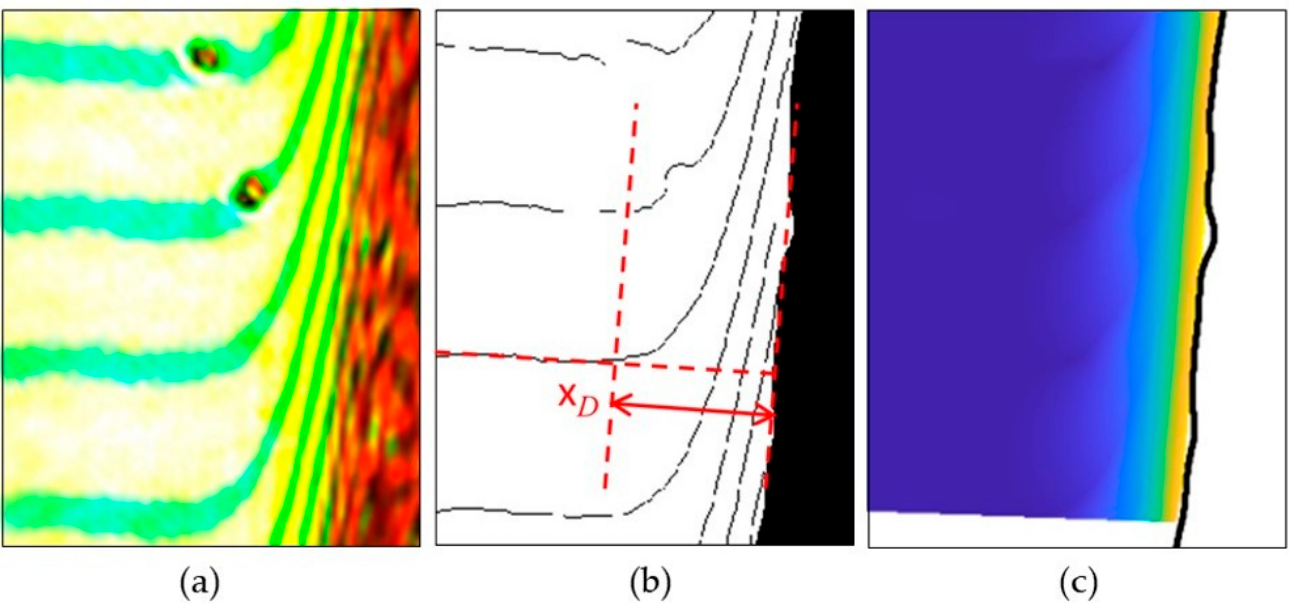
Figure 5. Extraction of the concentration field ( a ) original image, ( b ) determination of diffusive layer thickness and ( c ) calculated concentration field.